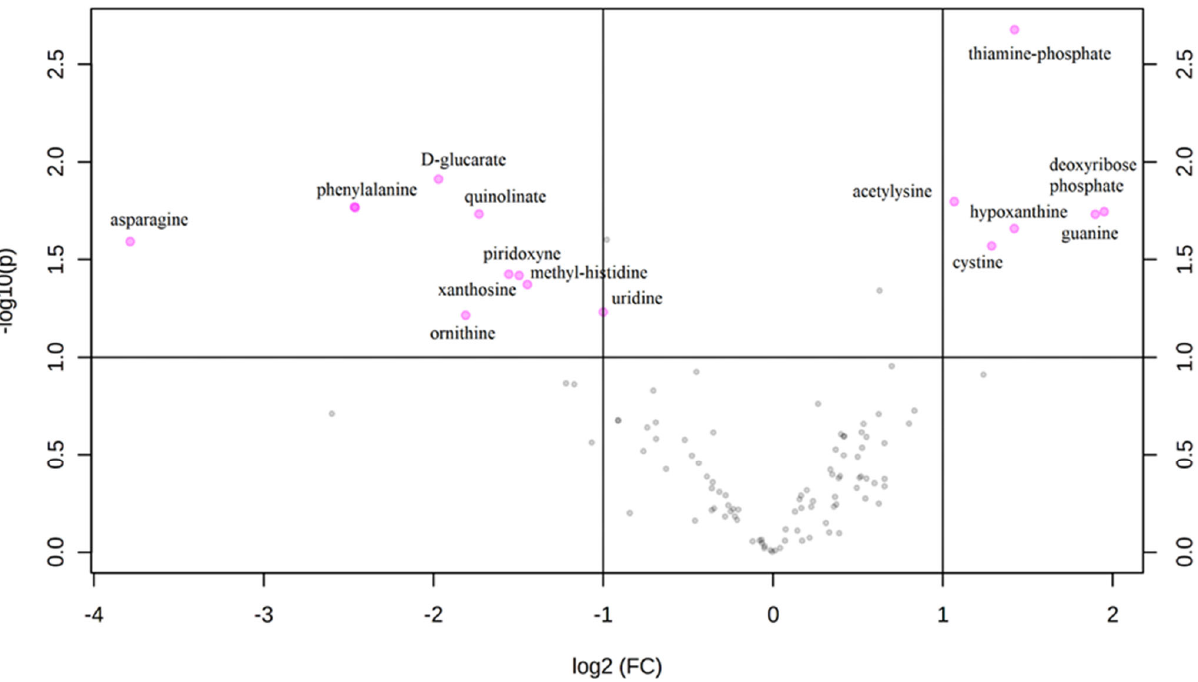
Figure 2. Volcano plot: each point on the volcano plot was based on both p -value and fold-change values, and in this study, these two values were set at 0.05 and 2.0, respectively. The points that satisfy the condition p < 0.05 and fold change > 2.0 appear in pink color and are marker candidates, whereas the others appear in gray and do not reach significance. On the x -axis, log2 (FC) is positive when ASD > SIB and negative when ASD < SIB, so pink dots on the right side of the figure represent metabolites significantly upregulated in autistic patients, and the pink dots on the left side repre- sent the down-regulated metabolites. The x -axis corresponds to log2 (fold change), and the y -axis corresponds to –log10 ( p